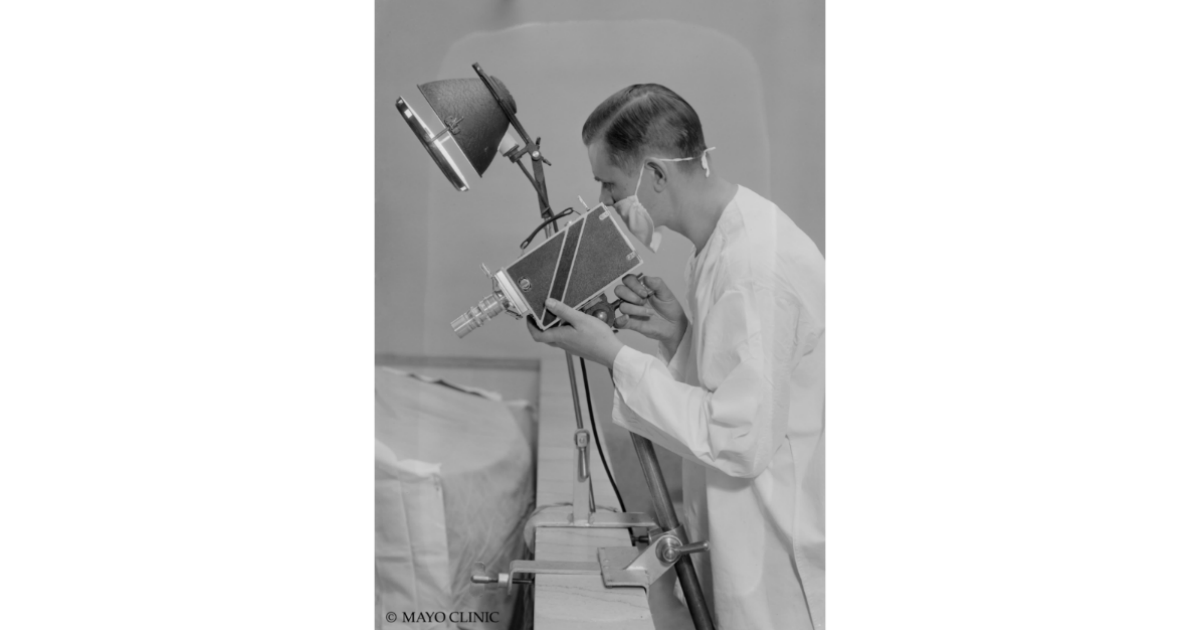
Figure 1. Videographer recording a surgical procedure at Mayo Clinic in Rochester, Minnesota, in March 1937. Copyright 1937 Mayo Foundation for Medical Education and Research. Used with the permission of Mayo Foundation for Medical Education and Research, all rights